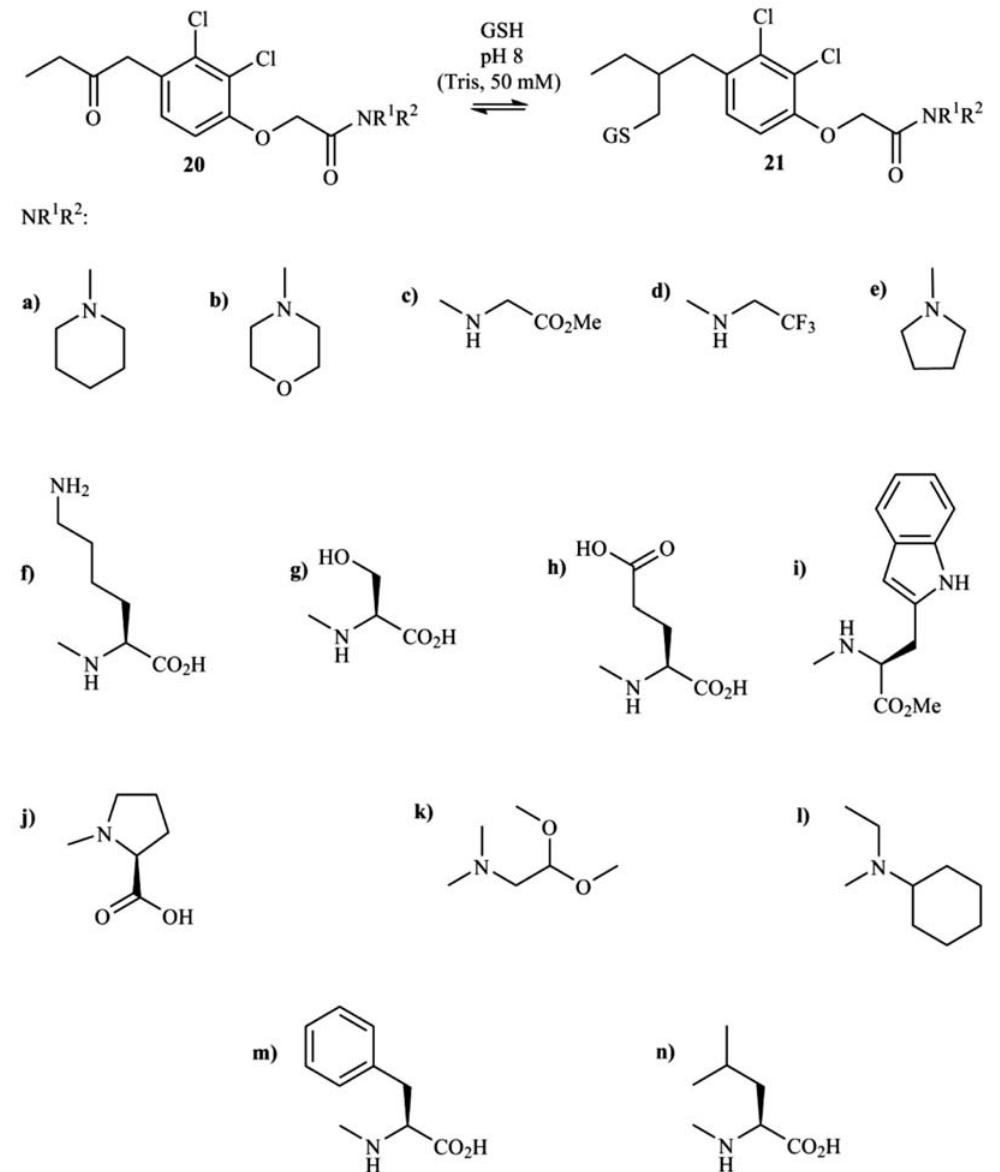
Figure 5. A nonbiased DCL of potential GST inhibitors generated from glutathione (GSH) and 14 enone ethacrynic acid analogues.